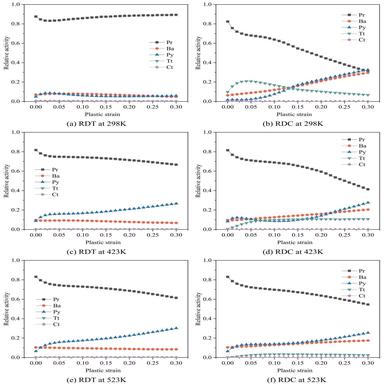
Deformation modes for the RDT and RDC at different temperatures show that the relative activity of Tt decreases with temperature, and the T-C asymmetry in terms of slip activity also decreases.